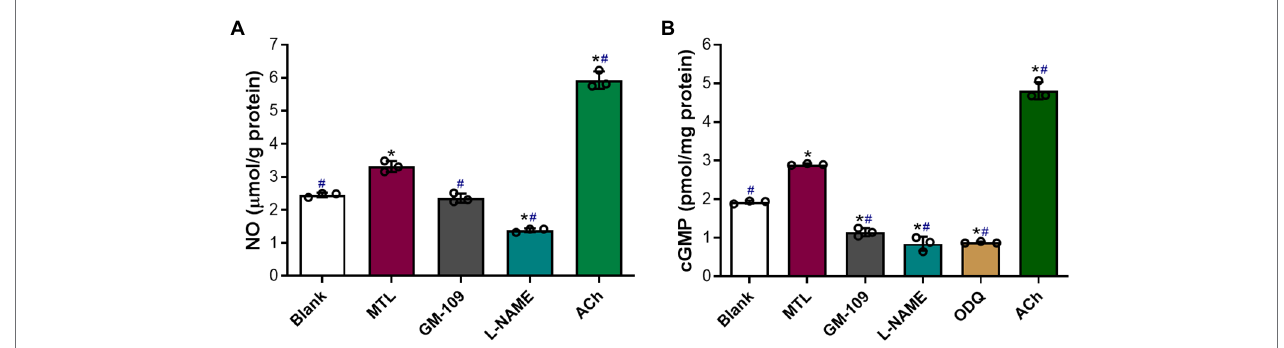
FIGURE 10 | Roles of the MLNR and its signal transduction pathway in the motilin-induced production of NO and cGMP in LGA tissues. (A,B) Effect of agonists and inhibitors on the production of NO and cGMP in the LGA. Data are means ± SEM ( n = 3). * p < 0.05 vs. blank group; # p < 0.05 vs. motilin group by one-way ANOVA. The following drug concentrations were used: motilin, 9 × 10 − 8 M; ACh, 10 − 5 M; GM-109, 10 − 5 M; L-NAME, 10 − 4 M; and ODQ, 10 − 5 M. ACh, acetylcholine; ANOVA, analysis of variance; cGMP, cyclic guanosine monophosphate; GM-109, MLNR antagonist; L-NAME, N-nitro-L-arginine methyl ester (NOS inhibitor); LGA,